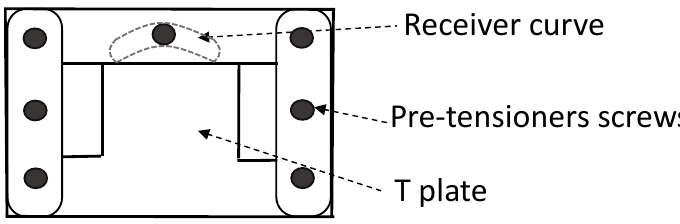
Figure 5. Construction of the improved Pall friction damper proposed by Wu et al.